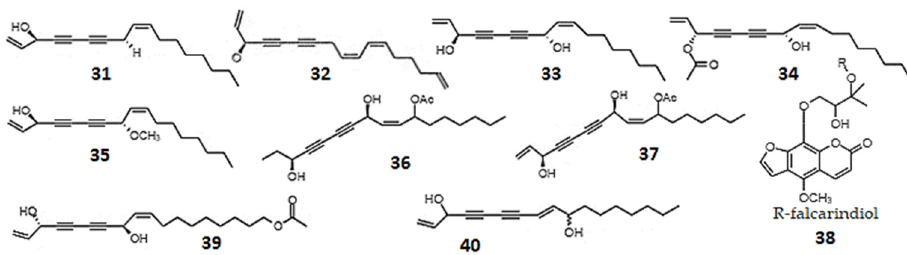
Figure 5. Chemical structures of plant oxylipins, derivatives of acetylenic fatty acids: falcarinol ( 31 ); didehydrofalcarinol ( 32 ); falcarindiol ( 33 ); falcarindiol-3-acetate ( 34 ); falcarindiol-8-methyl ether ( 35 ); 1,2-dihydro-11-acetoxy-falcarindiol ( 36 ); 11-acetoxy-falcarindiol ( 37 ); furanocoumarin ethers of falcarindiol, where R indicates falcarindiol ( 38 ); 11( S ),16( R )-dihydroxy-octadeca-9Z,17-dien-12,14- diyn-1-yl acetate ( 39 ); and panaxydiol ( 40 ).